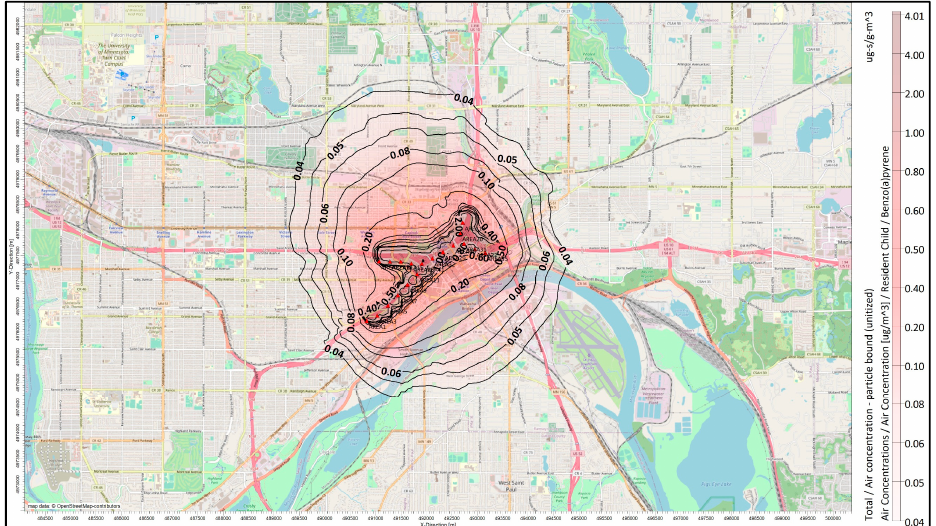
Figure 12. BaP Annual Air Concentration—Particle-Bound Phase (Unitized) Contour Plot overlaid on OpenStreetMap Satellite Imagery (OpenStreetMap, n.d.). Unit used in contour is µg-s/g-m 3 . The contour plots in both Figures 11 and 12 show that the maximums have decreased as compared to the hourly air concentrations. The unitized maximum concentration values and their respective locations are shown in Table 8. Table 8. Benzo(a)pyrene Maximum Concentration Values and their Respective Locations .